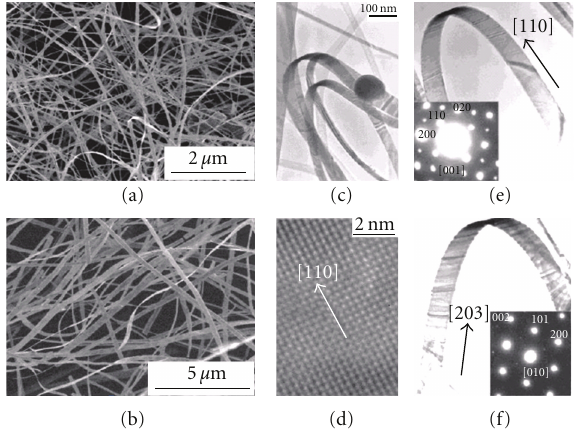
Figure 3: SEM images of SnO 2 (a) wire-like nanostructures and (b) nanoribbons, and TEM images (c)–(f) of SnO 2 nanoribbons.